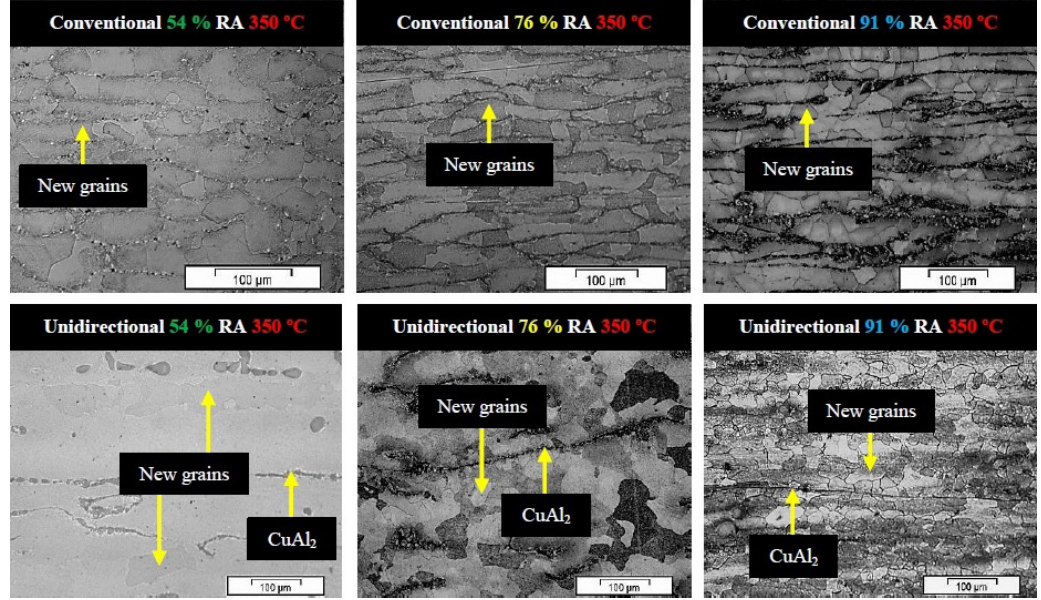
Figure 7. Micrographs of the Al4.5wt%Cu alloy conventionally and unidirectionally solidified after 54, 76 and 91% of RA and heat treatment of 350 ºC.